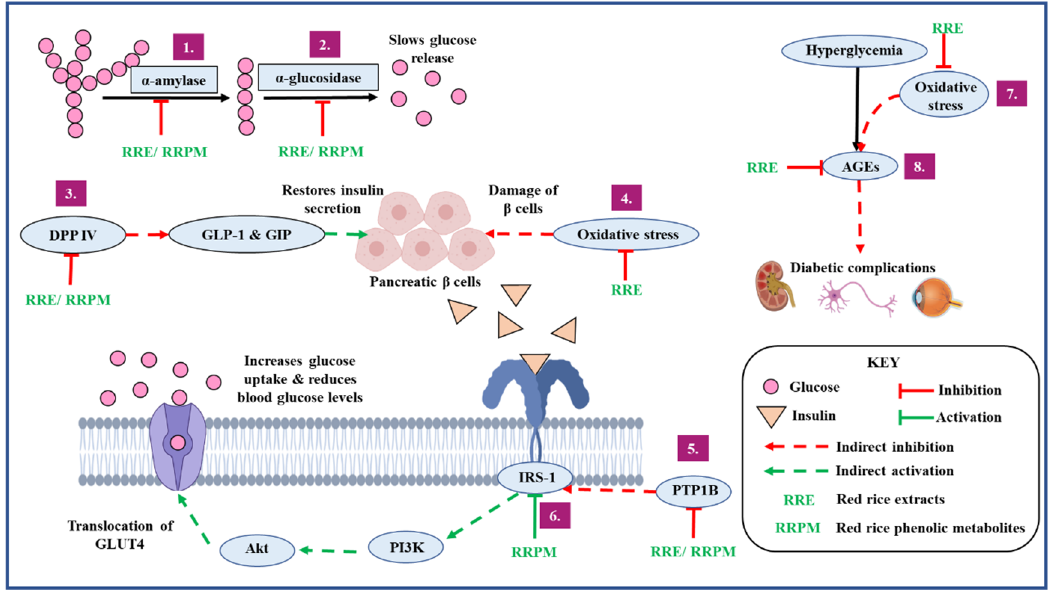
Figure 5. Antidiabetic mechanisms identified in experimental red rice extracts and phenolic metabolites using in vitro and. in silico evaluation.